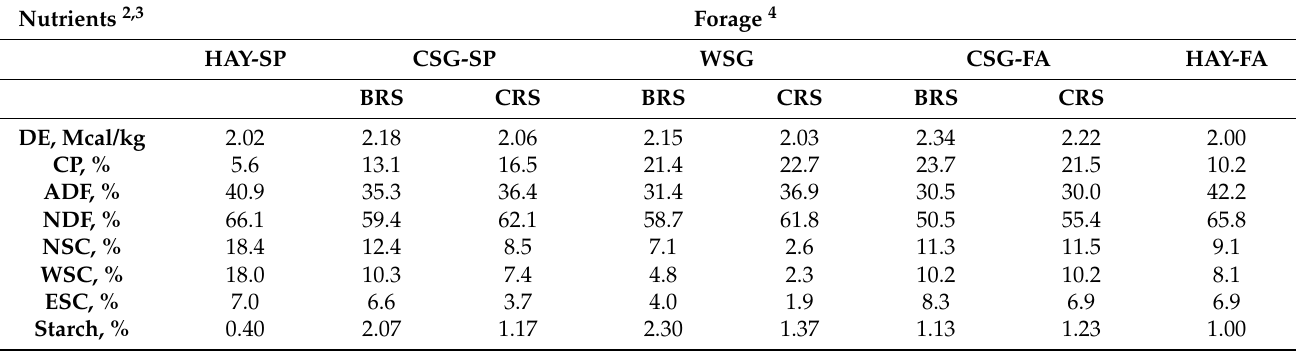
Table 1. Nutrient composition 1 of hay diets and pasture